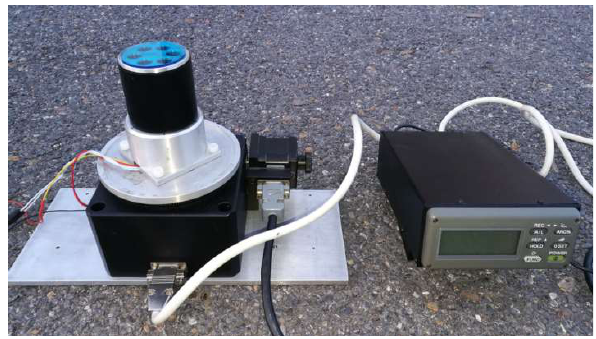
Figure 22. Photograph of outdoor setup.